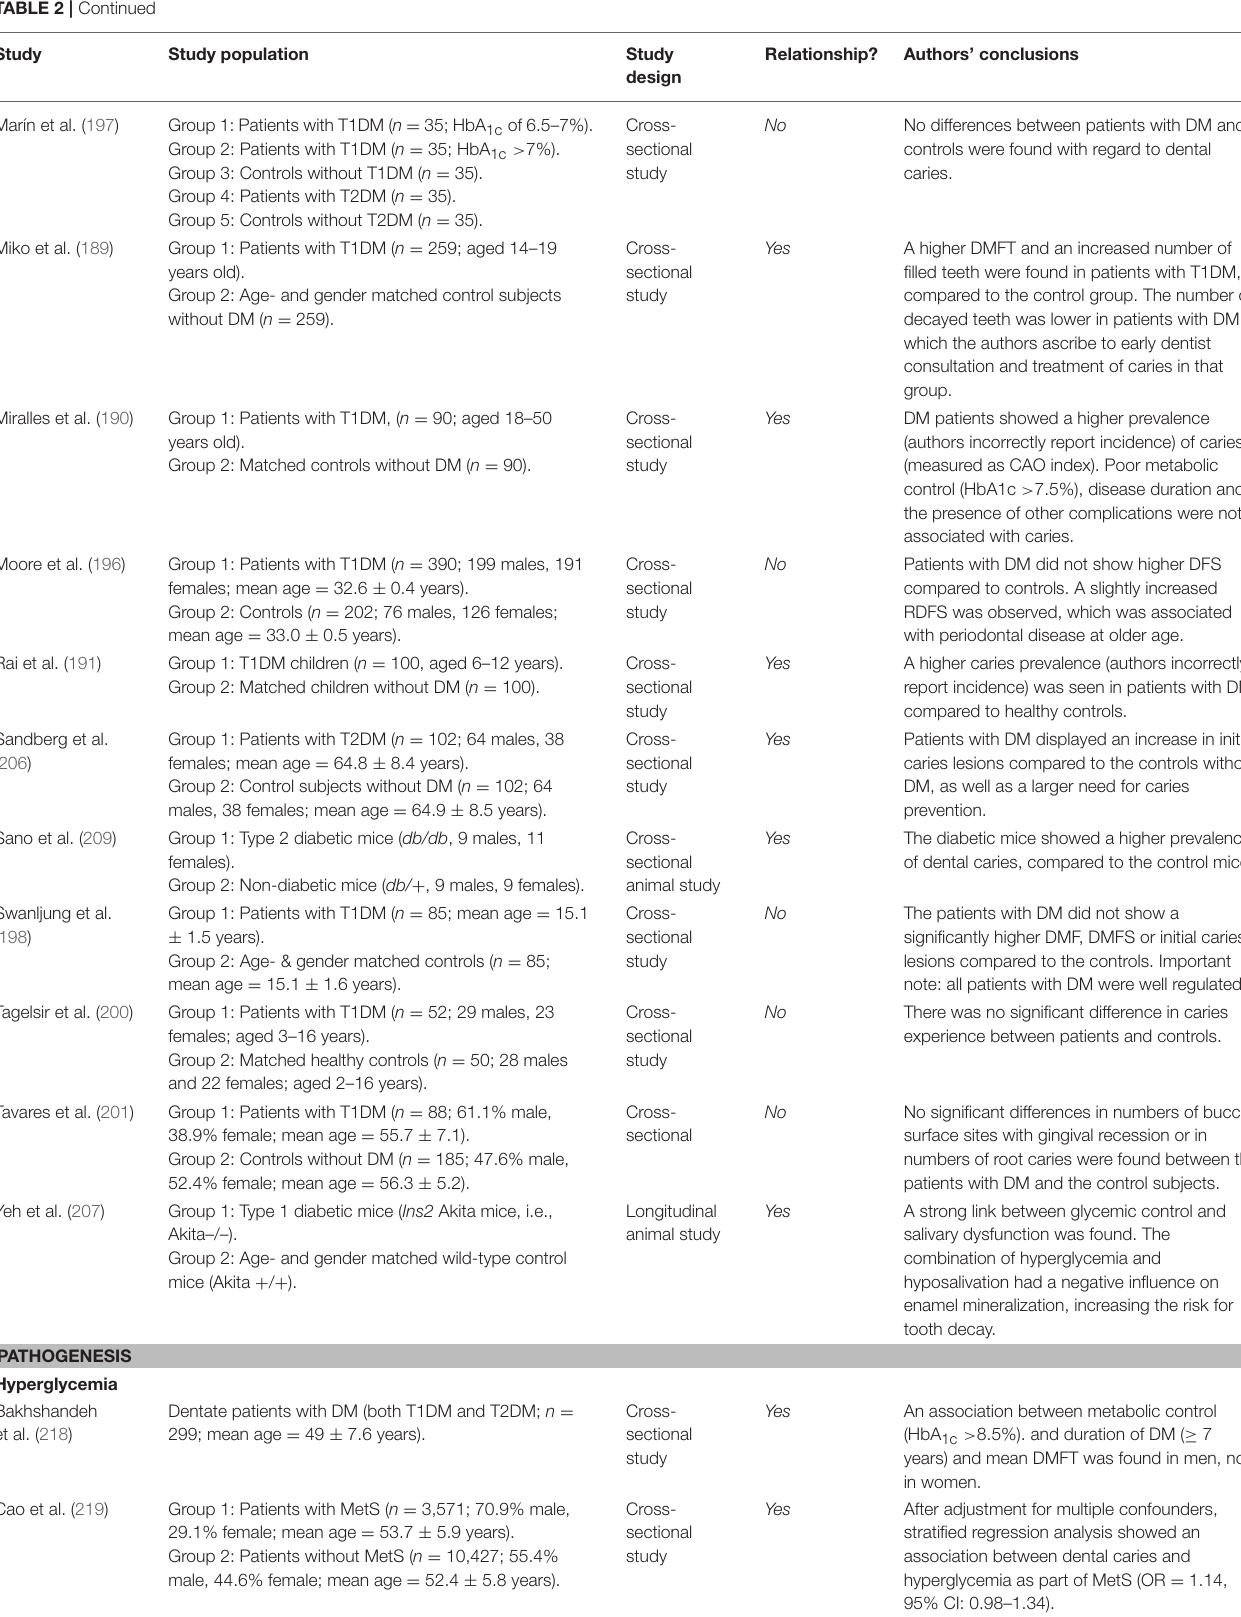
No No differences between patients with DM and Cross- controls were found with regard to dental sectional caries. study